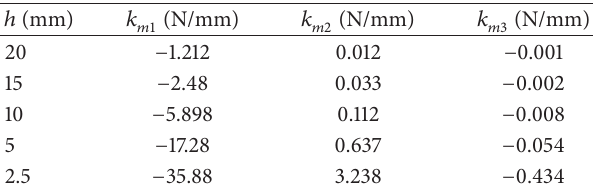
Table 2: Parameters for approximate